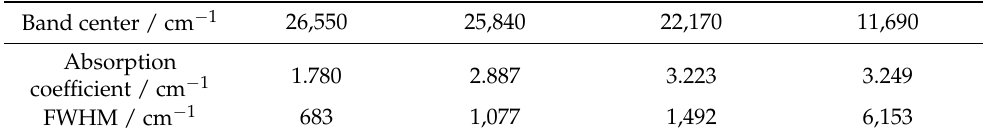
Table 2. Intensity and FWHM of absorption bands obtained by